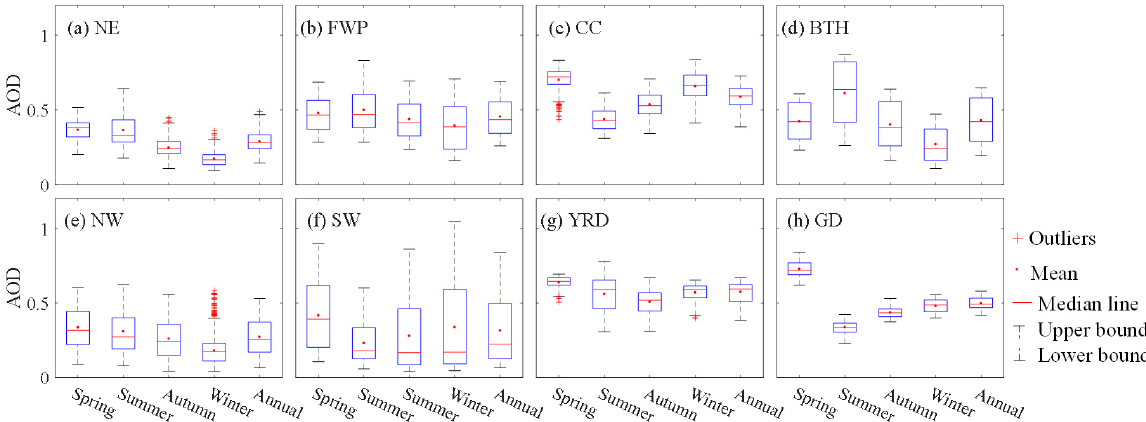
Figure 6. Statistics of seasonal and annual average AOD values in different areas. Note: the outliers indicate the extreme great/minor values of the data, which were calculated as the values beyond the upper and lower bounds of the data.